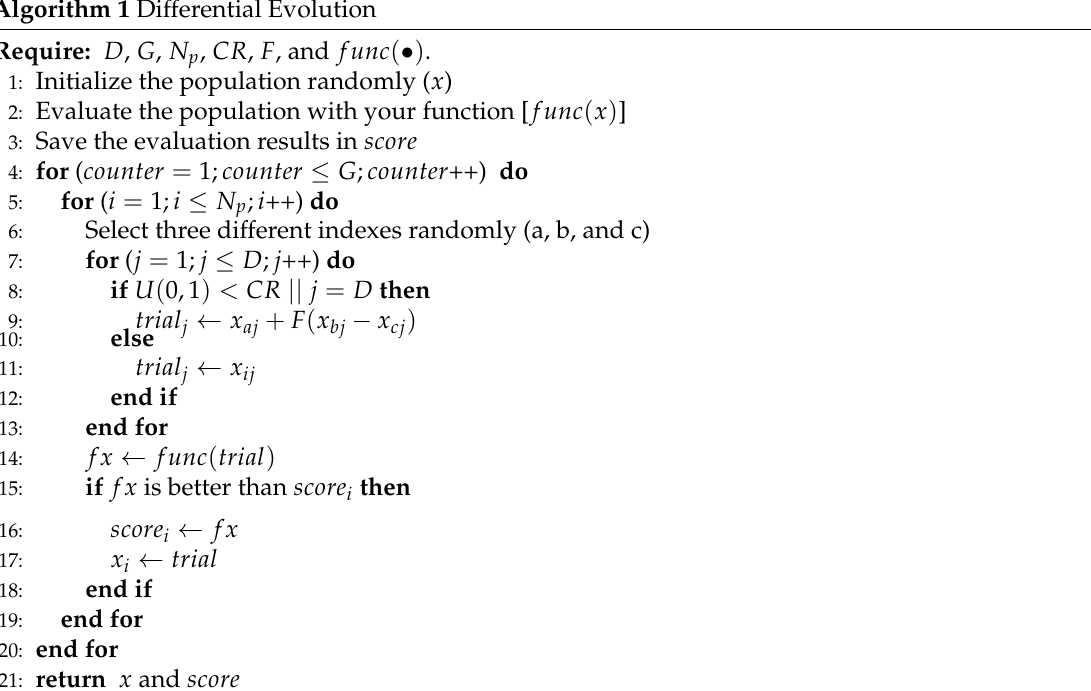
Algorithm 1 Differential